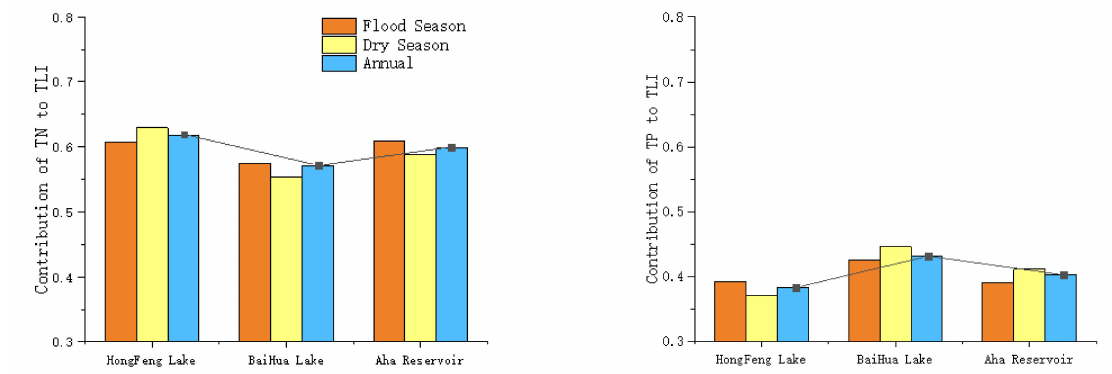
Figure 9. Contribution rates of TN ( left ) and TP ( right ) to TLI in the tributaries. The TP contribution rate to the TLI is higher in the tributaries than in the